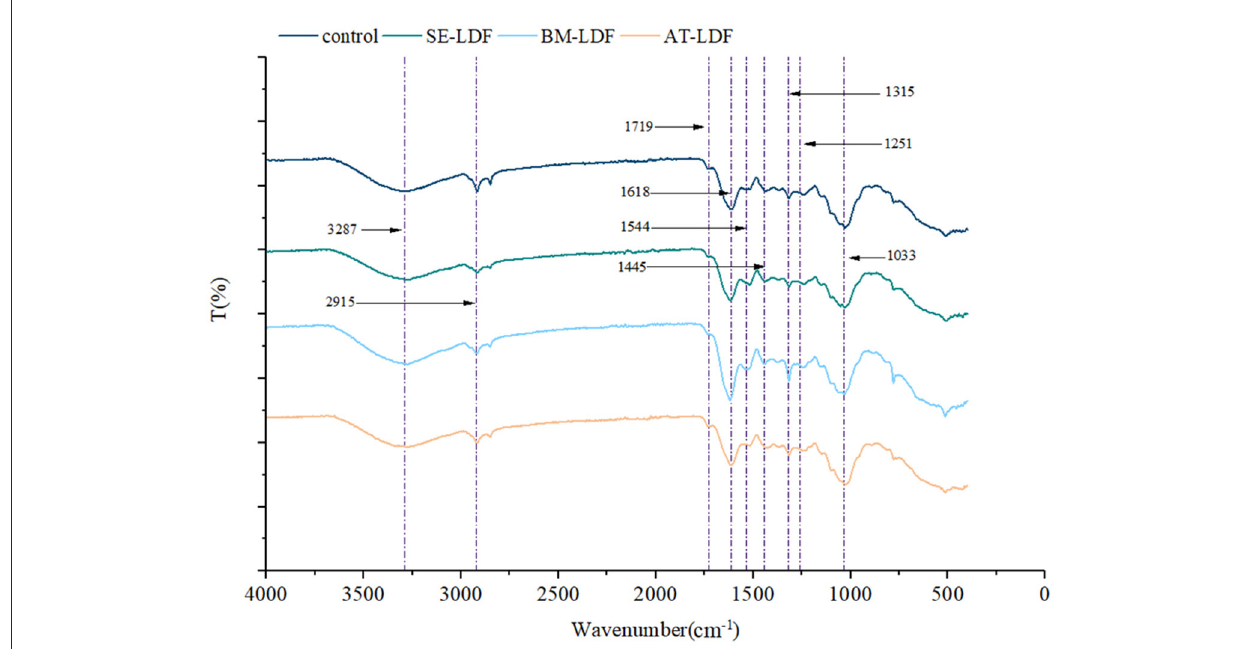
FIGURE2 FT-IR spectra of control, SE-LDF, BM-LDF, and AT-LDF. Control: lotus leaves dietary fiber. SE-LDF, shear emulsifying modified lotus leaves dietary fiber; BM-LDF, ball milling modified lotus leaves dietary fiber; AT-LDF, autoclave modified lotus leaves dietary fiber.